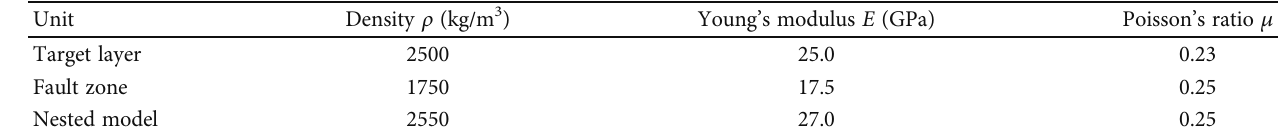
Figure 6: Geometry (a) and meshing results (b) of the initial Haiba 3D Table 1: Reservoir rock mechanics parameters used in this study.